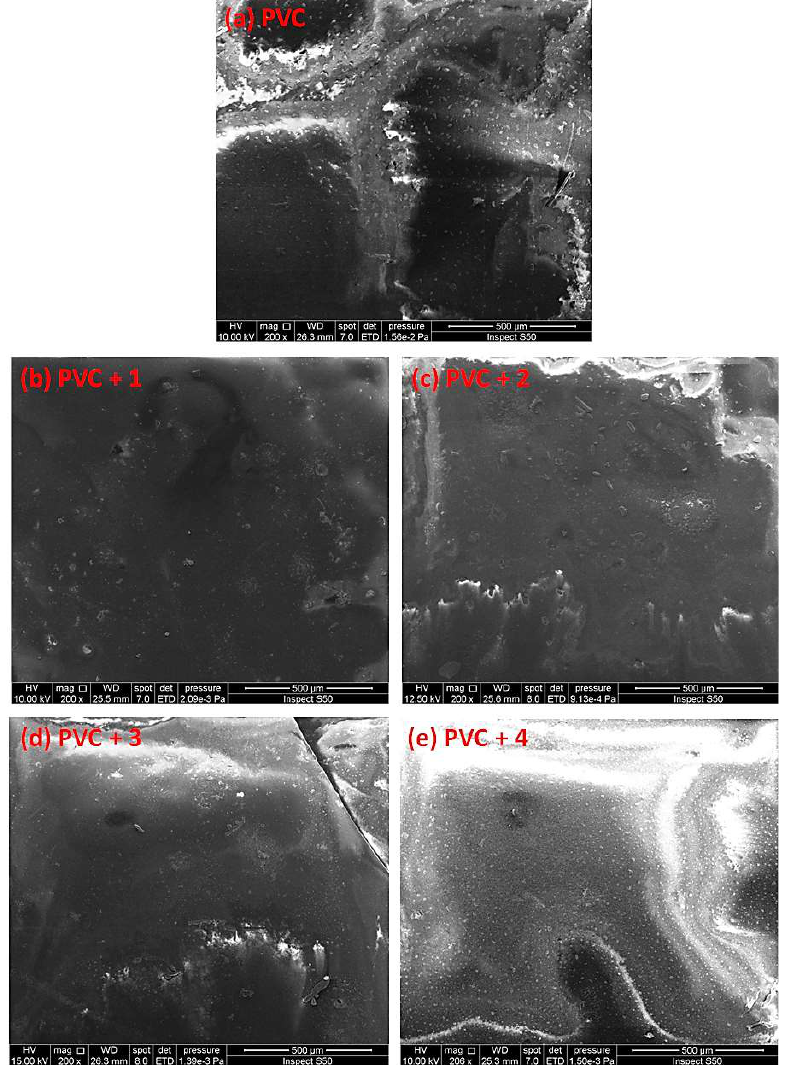
Figure 12. SEM images of the ( a ) blank PVC film and ( b – e ) PVC films containing tin(IV) compounds 1 – 4 after irradiation (300 h). 1 – 4 after irradiation (300